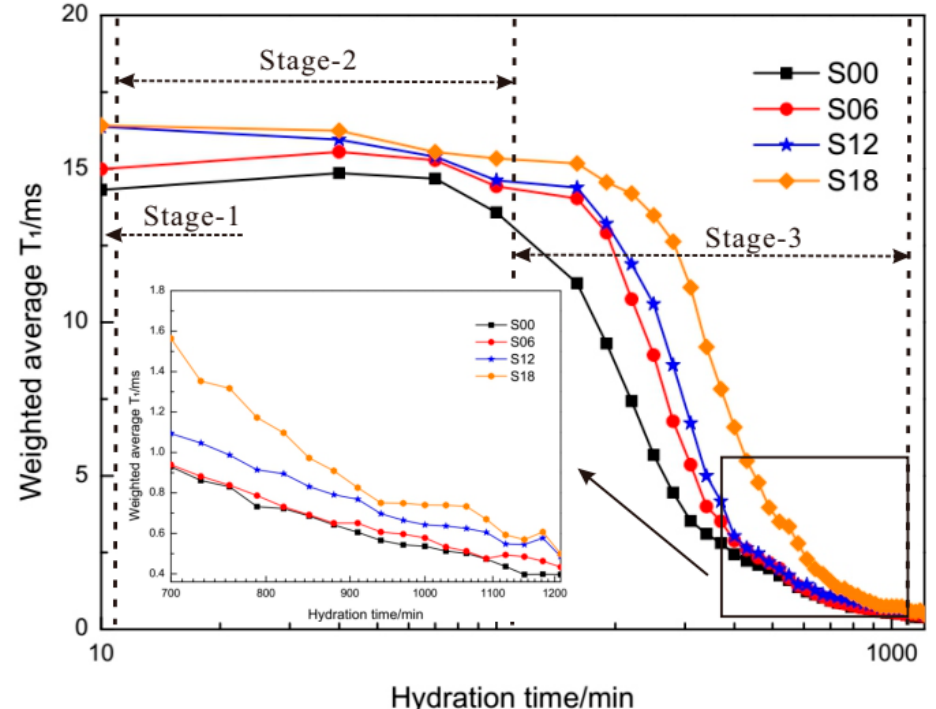
Figure 7. Time ‐ dependent evolution of weighted average T 1 of different cement pastes within 1210